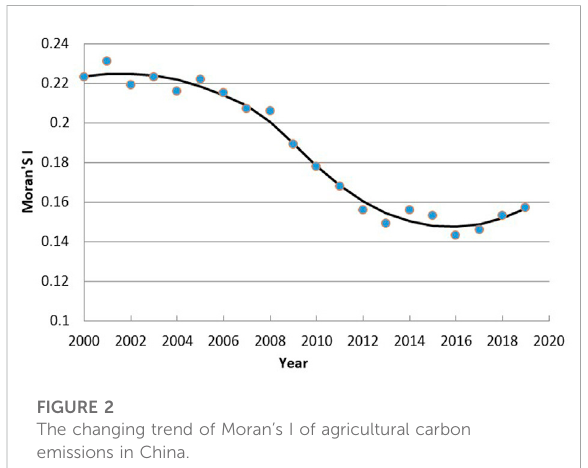
FIGURE 2 The changing trend of Moran ’ s I of agricultural carbon emissions in